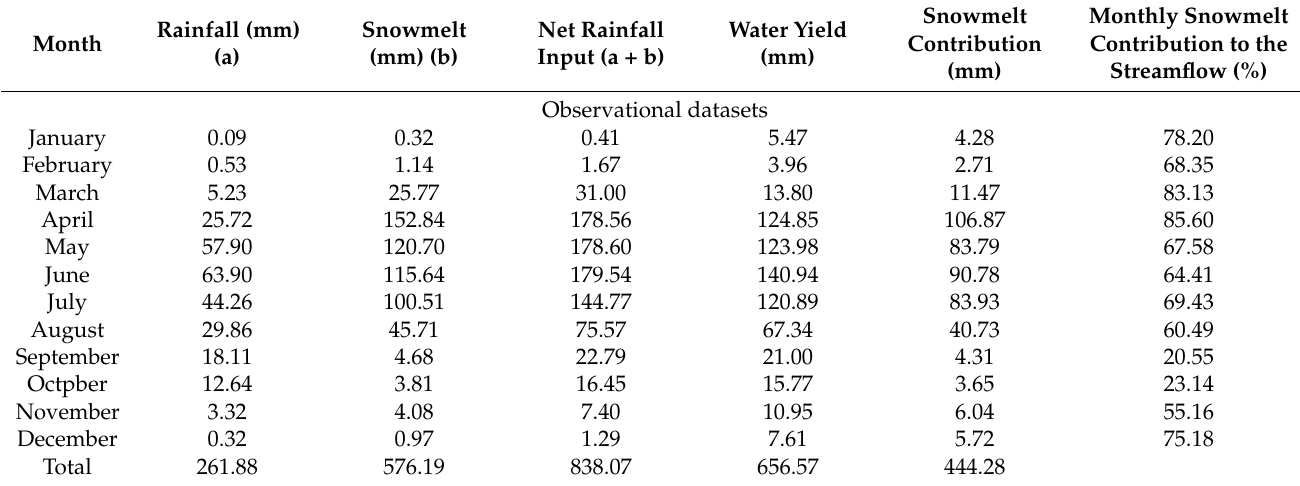
Table 7. Average monthly snowmelt contribution in the Upper Vakhsh River flow, by coupling the SWAT model with the observational datasets, during the overall period of the SWAT model